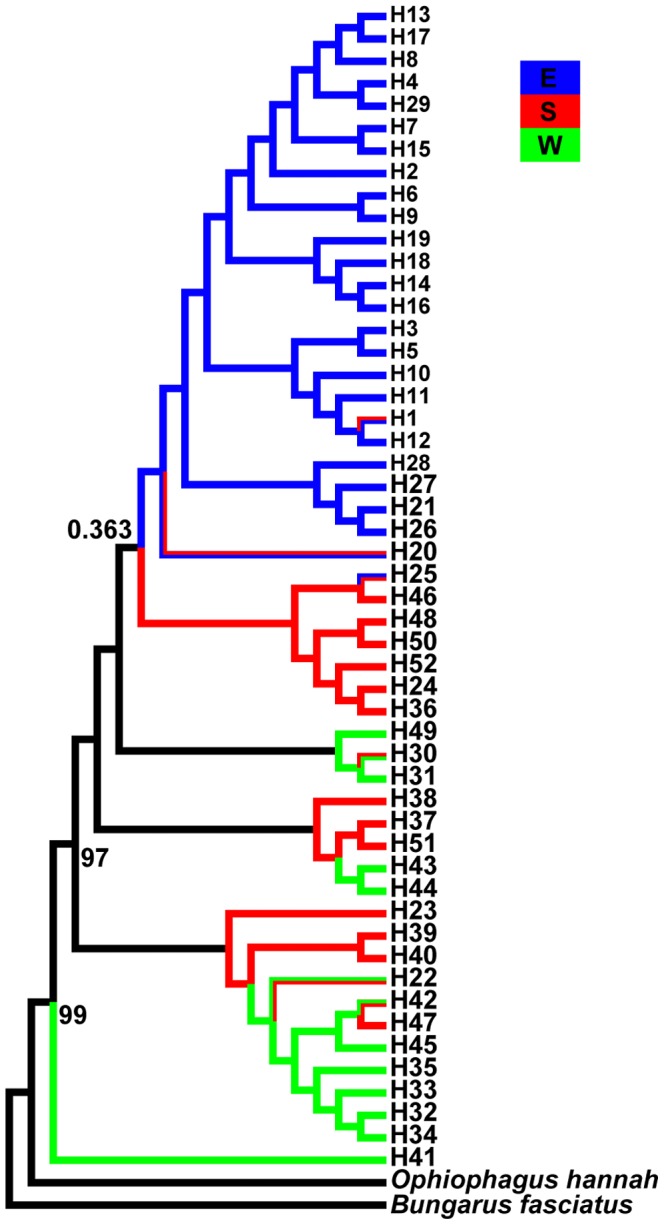
Maximum-likelihood tree for all 52 haplotypes of Naja atra, with Ophiophagus hannah and Bungarus fasciatus as the outgroup taxa. Labels are haplotype identification numbers.Values on the right side of the nodes indicate support for each node based on maximum likelihood. Bootstrap values below 60% are not shown. The value of 0.363 mya above the branch indicates the divergence time between the eastern population groups and the other two population groups.